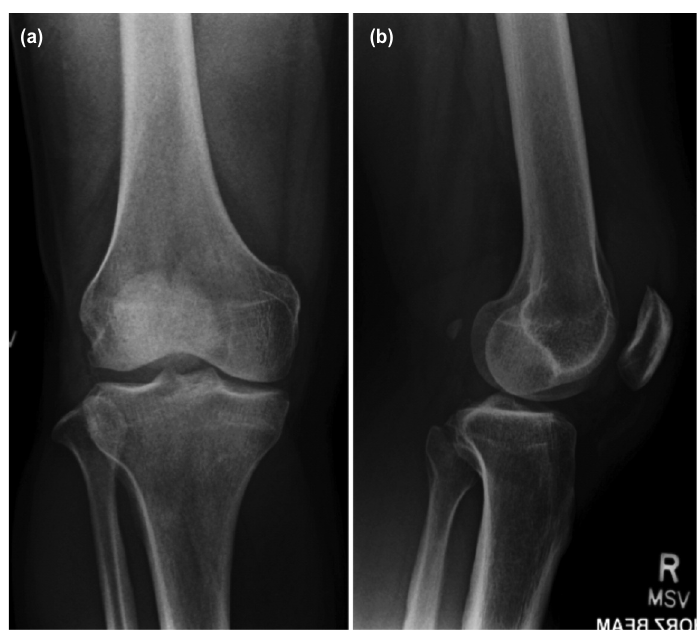
(a) Antero-posterior and (b) lateral radiographs of the right knee did not reveal any radiographic signs of chondrocalcinosis. Fig. 1: